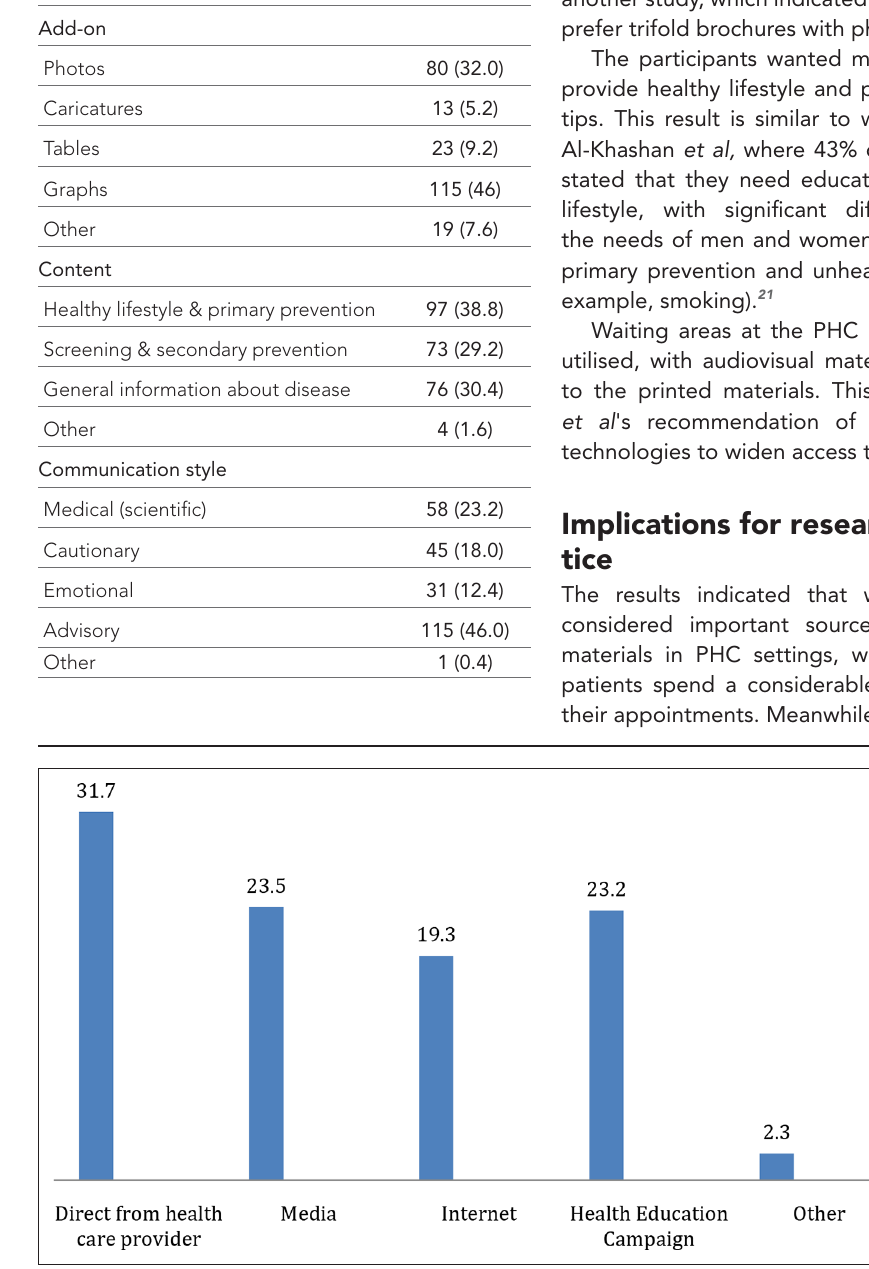
Figure 3 Participants' preferred method of health education other than printed materials in